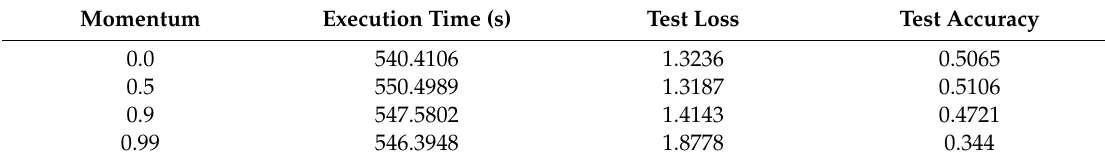
Table 13. E ff ect of momentum on RNN.